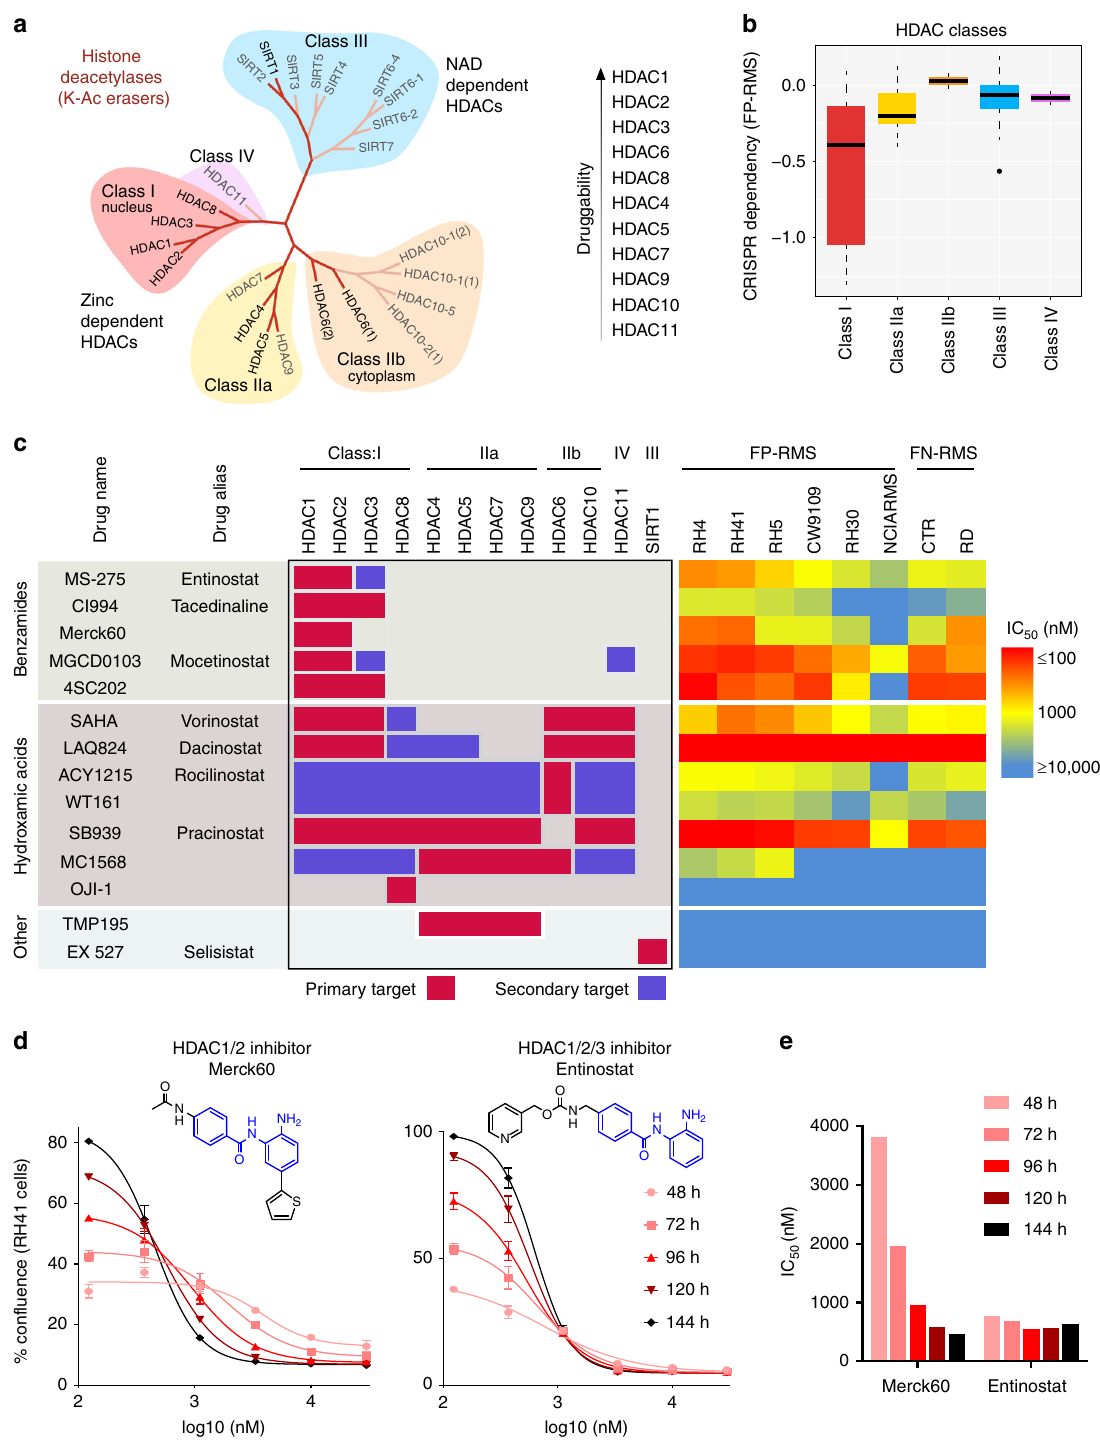
Fig. 3 Chemical phylogenetics of HDAC sensitivity. a Phylogenetic tree of histone deacetylases. b CRISPR screening of HDAC isoforms in FP-RMS cells from Broad Achilles dataset reveals strongest dependency on Class I. The panel shows summary statistics as a box (quartiles) and whisker (1.5*inter- quartile range) plot. c Diverse HDAC inhibitors with varying selectivity for HDAC isoforms, shown on the left, with each compounds concentration of half- maximal ef fi cacy (IC 50 ) on the right (measured by impact on cell growth over time). d Dose – response curves of RH41 cell growth impaired by benzamide- based inhibitors of HDAC1/2 (Merck60) and HDAC1/2/3 (Entinostat) over time. Points represent mean and error bars show SEM of triplicate measurements. e Rapid stabilization of IC 50 from Entinostat, compared to gradual decline in IC 50 with Merck60, corresponding to RH41 cell growth data presented in